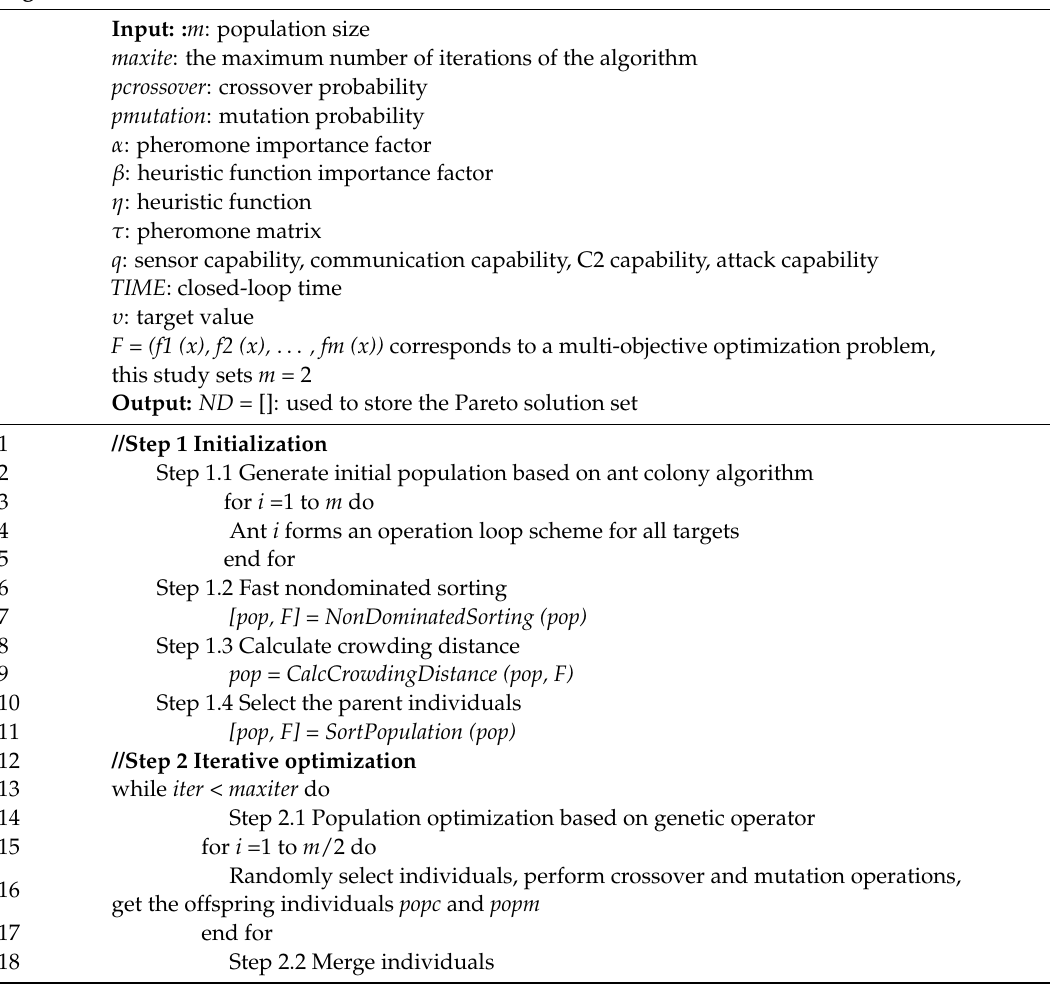
Algorithm A1. Pseudocode of